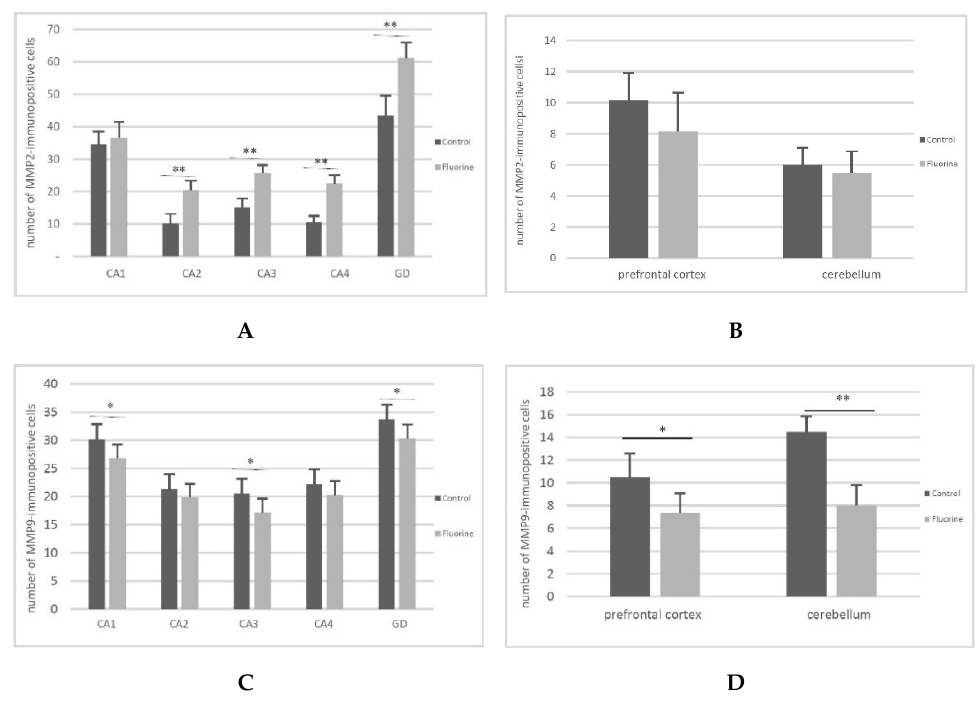
Figure 3. The number of MMP2-immunopositive cells in the hippocampus ( A ) and in the prefrontal cortex and cerebellum ( B ) and the number of MMP9-immunopositive cells in the hippocampus ( C ) and in the prefrontal cortex and cerebellum ( D ). * p ≤ 0.05, ** p ≤ 0.005 (Mann–Whitney U test), n =